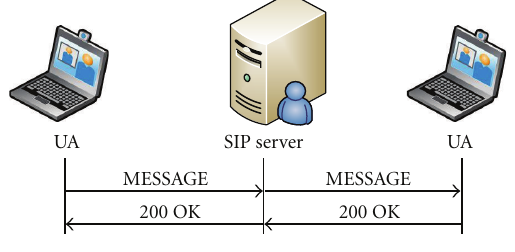
Figure 1: Page mode